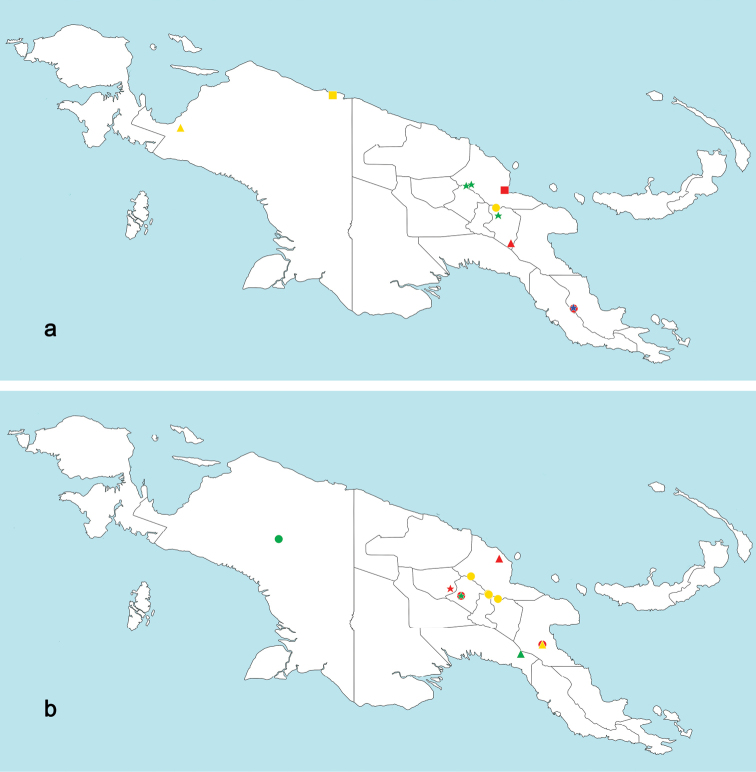
Distribution of Labiobaetis in New Guinea: a red circle, L.balkei sp. n.; blue star, L.lobatus sp. n.; yellow circle, L.michaeli sp. n.; red square, L.claudiae sp. n.; yellow square, L.stagnum sp. n.; red triangle, L.orientis sp. n.; yellow triangle, L.papuaensis sp. n.; green star, L.elisae sp. n. b red circle, L.petersorum; yellow circle, L.gladius sp. n.; green circle, L.janae sp. n.; green star, L.vultuosus; red star, L.paravultuosus sp. n.; yellow triangle, L.involutus; red triangle, L.vallus sp. n.; green triangle, L.inopinatus sp. n.